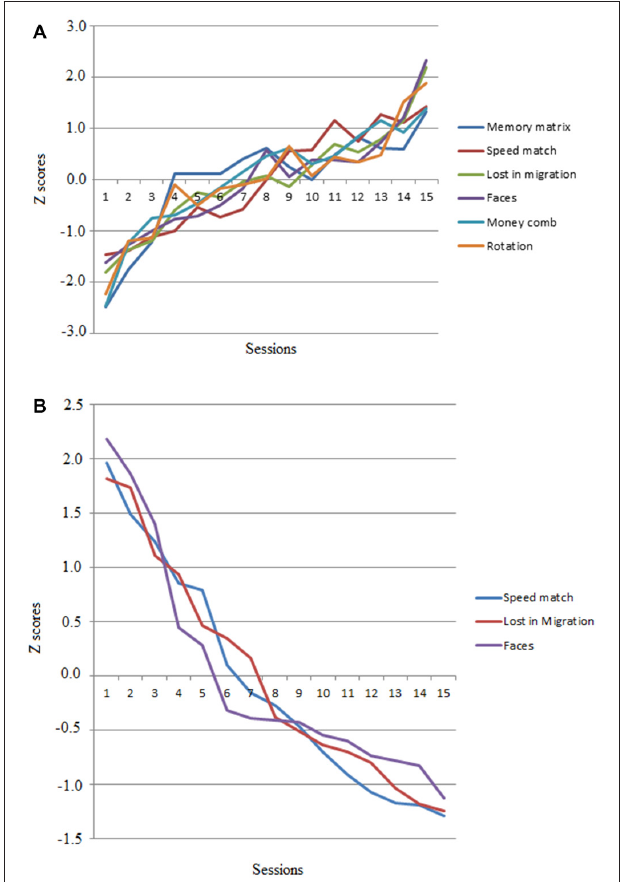
FIGURE 1 | (A) Average performance scores obtained in the six non-action video games across the 15 sessions in Z scores (mean 0; standard deviation 1). (B) Average response times of four video games across the training sessions in Z